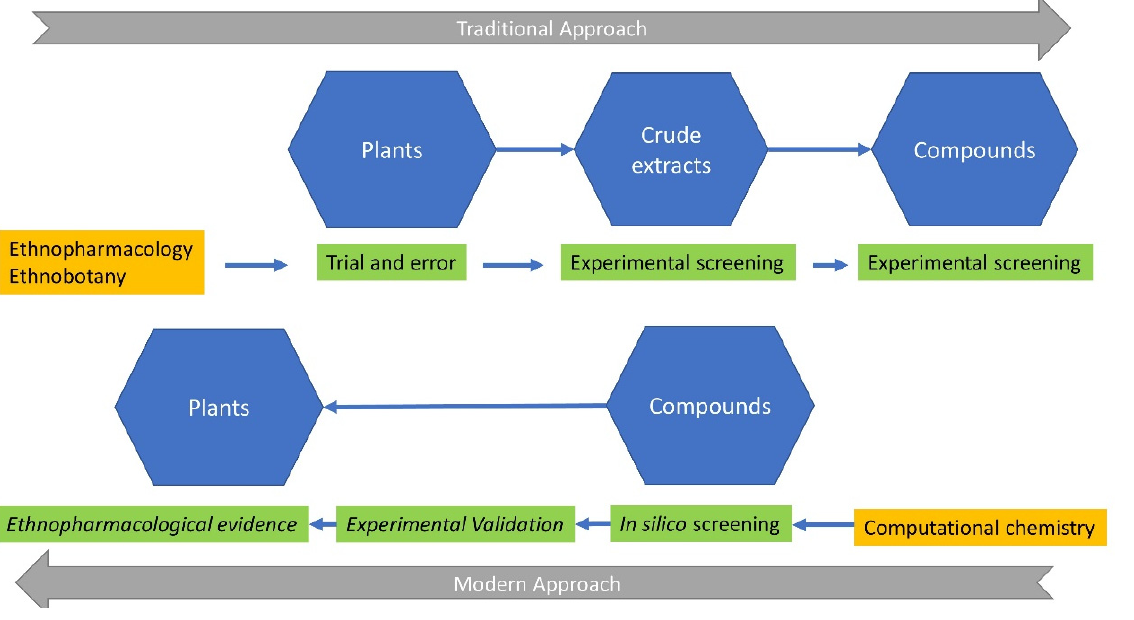
Figure 1. Scientific disciplines (orange color), methodologies (green color), and compartments (blue color) from traditional to modern approaches in ethnopharmacology. Arrows denote the transition from the trial-and-error methodologies of the indigenous people to the in silico screening of computational chemistry. It is of note, as discussed in the text, that modern ethnopharmacology incorporates the computational and experimental validation of active natural compounds, prior to the detection of ethnopharmacological evidence. See text for further details.